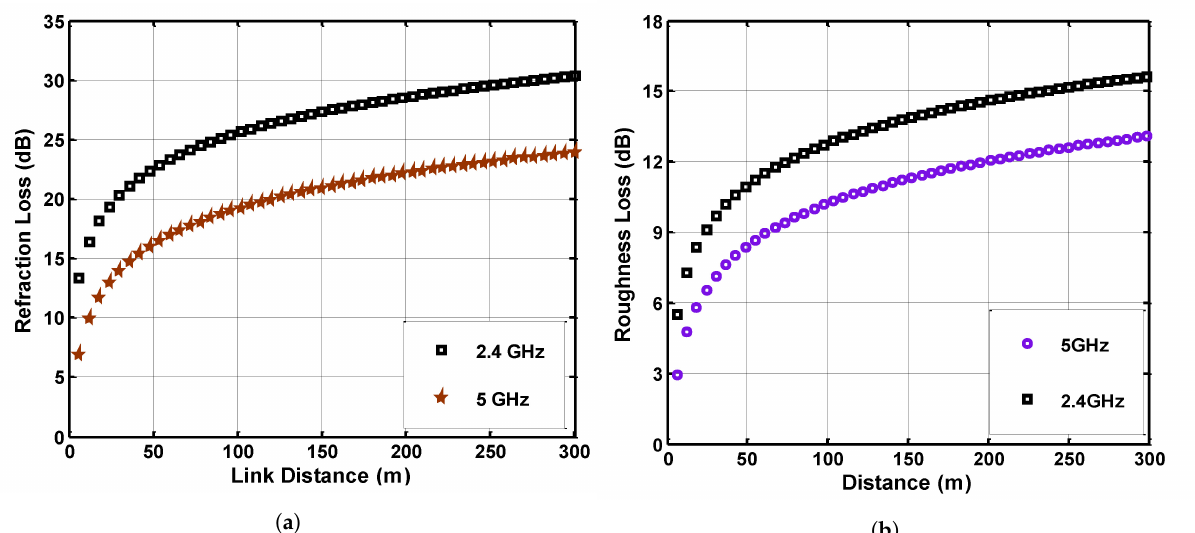
Figure 9. ( a ) Refraction loss at operating frequency of 2.4 GHz and 5 GHz, ( b ) Roughness loss at 2.4 GHz and 5